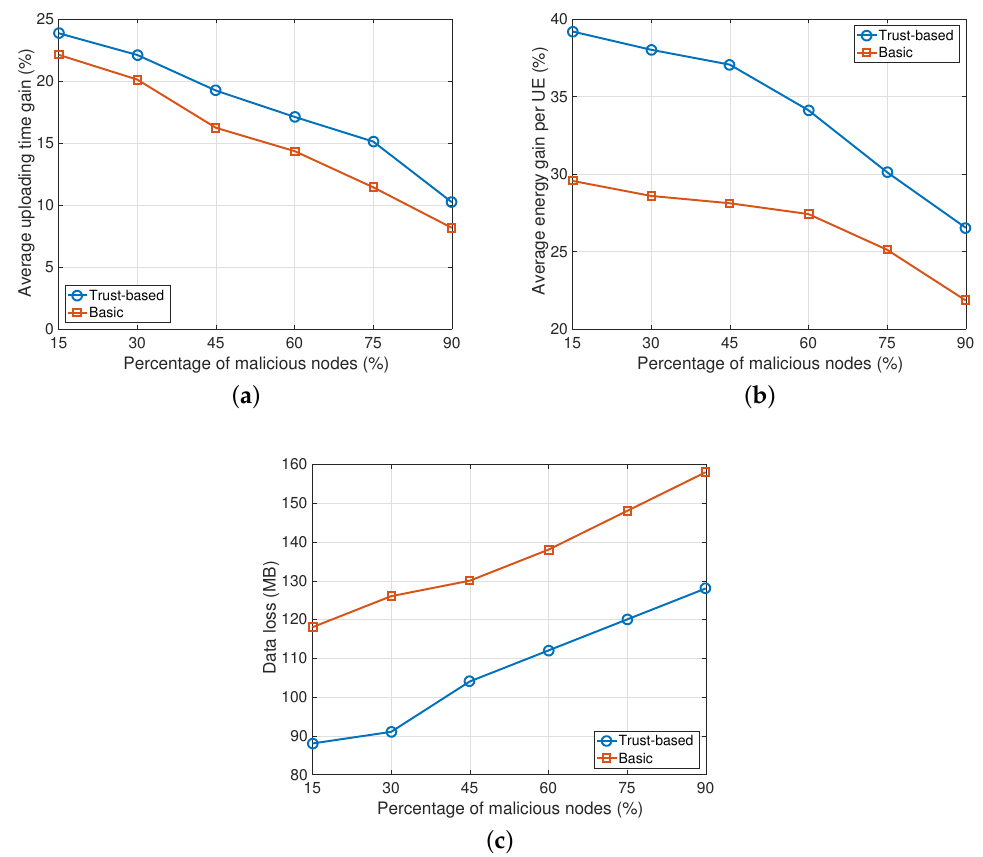
Figure 3. Impact of malicious nodes percentage (half of type A and half of type B malicious nodes are considered, FT = 0.5). ( a ) Uploading time gain; ( b ) Average energy gain; ( c ) Data